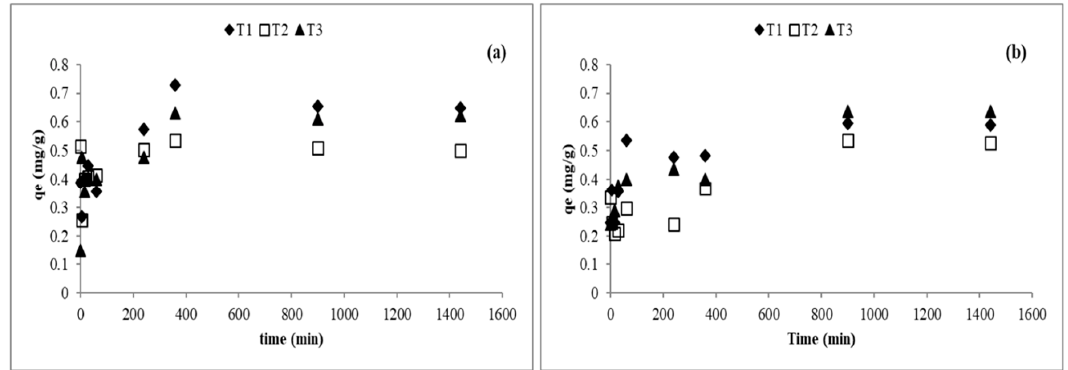
Figure 2. Effect of contact time on P sorption by soil 1 ( a ) and soil 2 ( b ). T1: triple superphosphate in water, T2: triple superphosphate in 0.01 M NaNO 3 , T3: NH 4 H 2 PO 4 in 0.01 M NaNO 3 . Experimental conditions: Initial P concentration 88.88 mg/L, sorbent/solution ratio 1 g/0.02 L, agitation rate 125 rpm, temperature 22 °C.